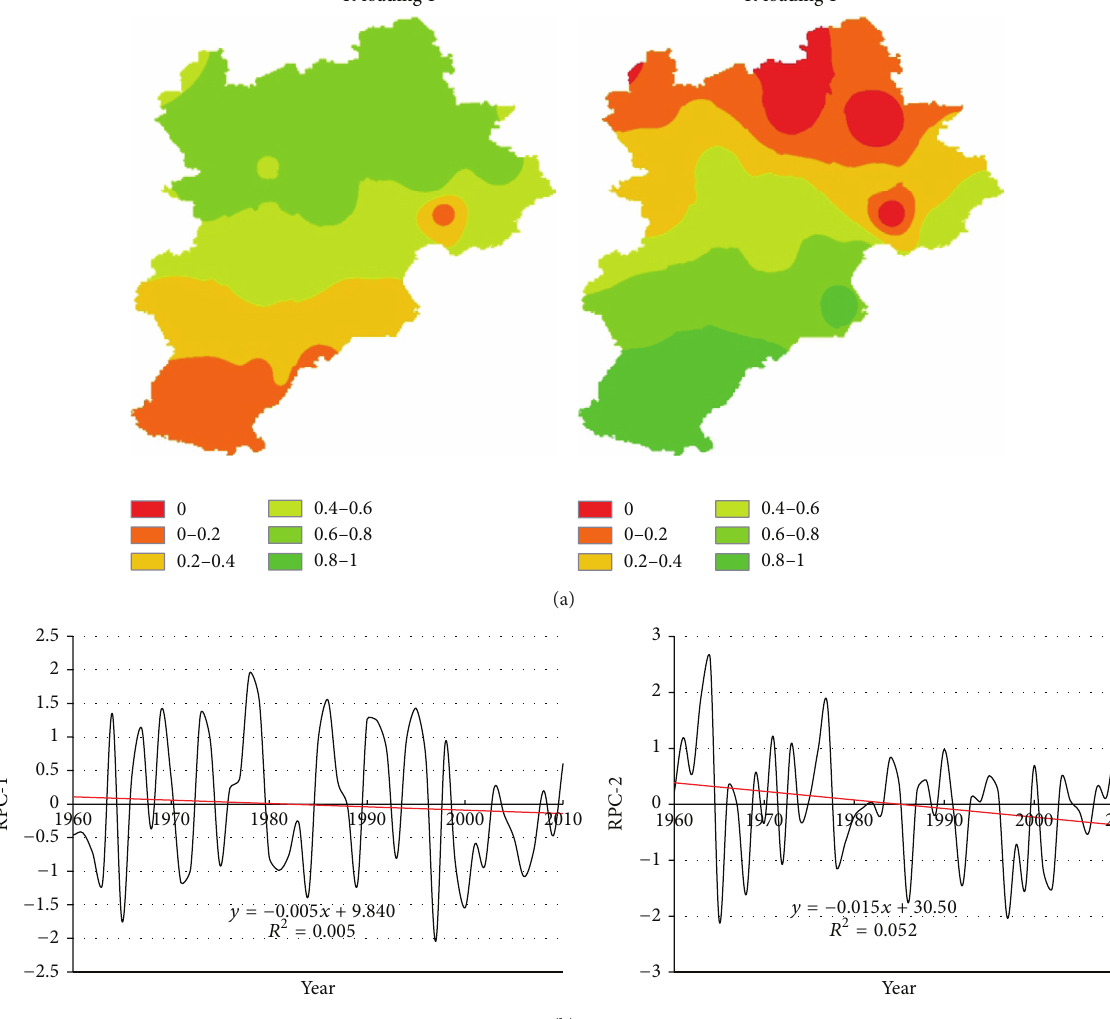
Figure 8: (a) Varimax rotated loading patterns (R-loading) of the RDI-12 and (b) time variability of the rotated PC scores (RPC) of the RDI-12 for the period 1960–2010 and the corresponding linear trend.